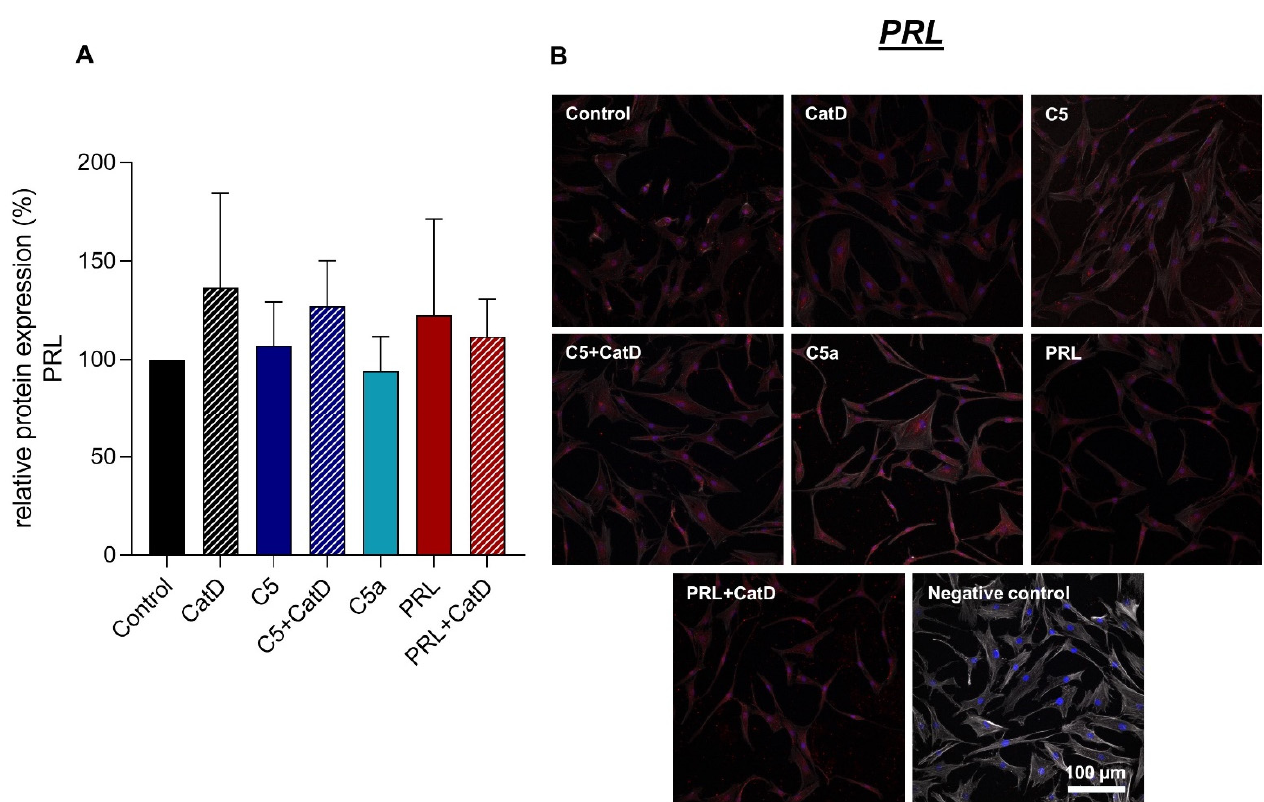
Figure 8. Chondrocytes protein expression of PRL after 72 h stimulation and negative control of the staining. n = 3 independent experiments with chondrocytes from different donors. ( A ): Graphic representation of relative PRL protein fluorescence intensity, mean with standard deviation. Control has been normalized to 1. One sample t-test with significance in relation to control. Mixed-effects analysis using post-hoc Tukey’s multiple comparisons. ( B ): representative images of chondrocytes immunolabeled with PRL specific antibodies. Red (Alexa Fluor 555) = PRL, blue (DAPI) = cell nuclei, grey (Phalloidin Alexa 633) = Actin cytoskeleton. Scale bar = 100 µm.